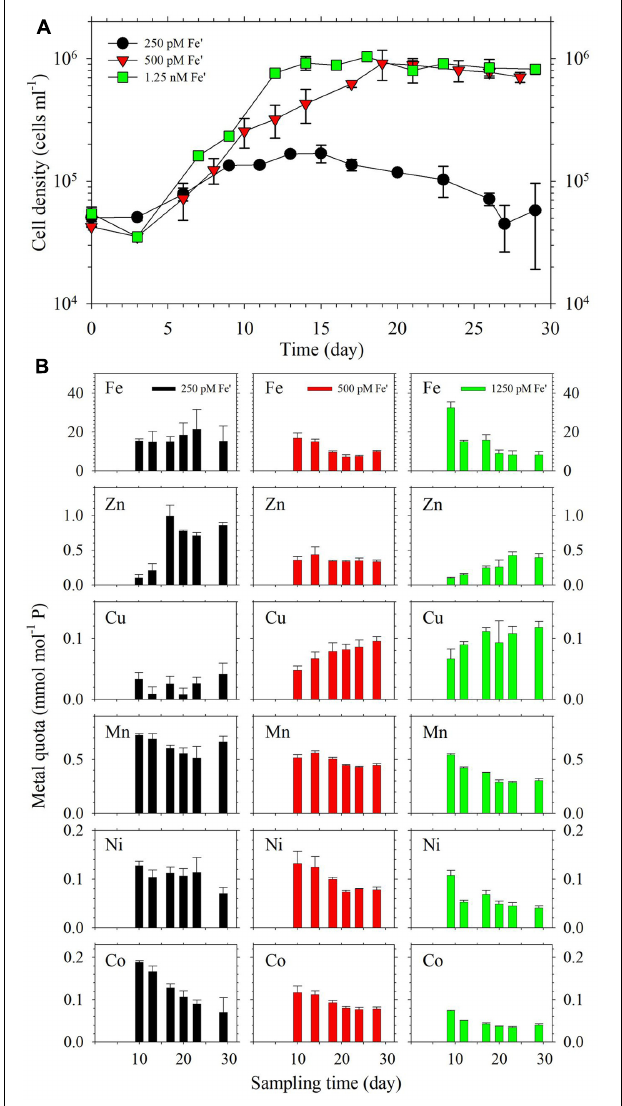
FIGURE 4 | (A) Growth curves and (B) intracellular metal quotas of S. kawagutii subjected to different Fe availability in continuous culture conditions. The other trace metals were supplied at the following concentrations: 12.5 pM Zn (cid:48) , 0.50 pM Cu (cid:48) , 4.2 nM Mn (cid:48) , 20 pM Co (cid:48) , and 6.7 pM Ni (cid:48) . Error bars represent average deviation of duplicate